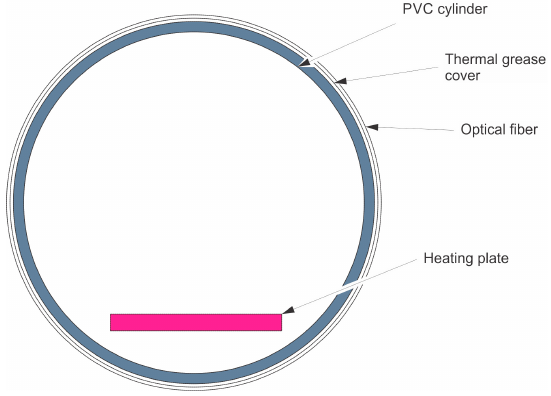
Figure 10. Cross-section of the setup at z = 20 mm.